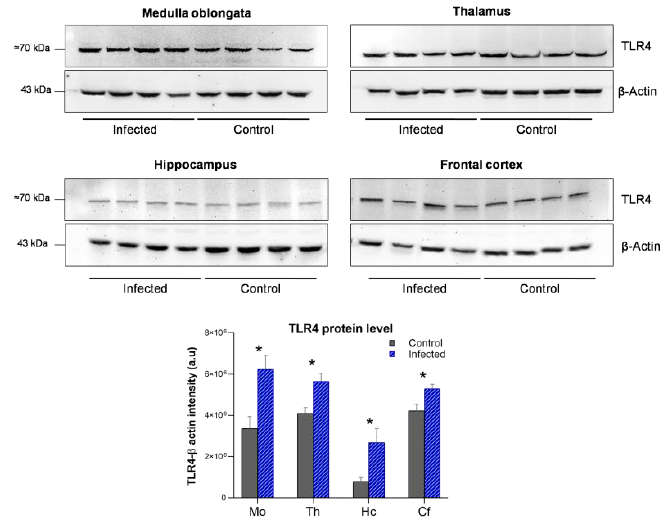
Figure 9. TLR4 protein expression in the medulla oblongata (Mo), thalamus (Th), hippocampus (Hc), and frontal cortex (Fc) of scrapie-infected sheep versus control sheep ( n = 4 per group). β -actin was used as a loading control. The graph depicts densitometry values and indicates a significant increase in TLR4 expression in all regions in scrapie-infected versus control sheep. Data are expressed as the mean ±SEM. Mean scores were compared using the Student’s t-test. * p < 0.05.